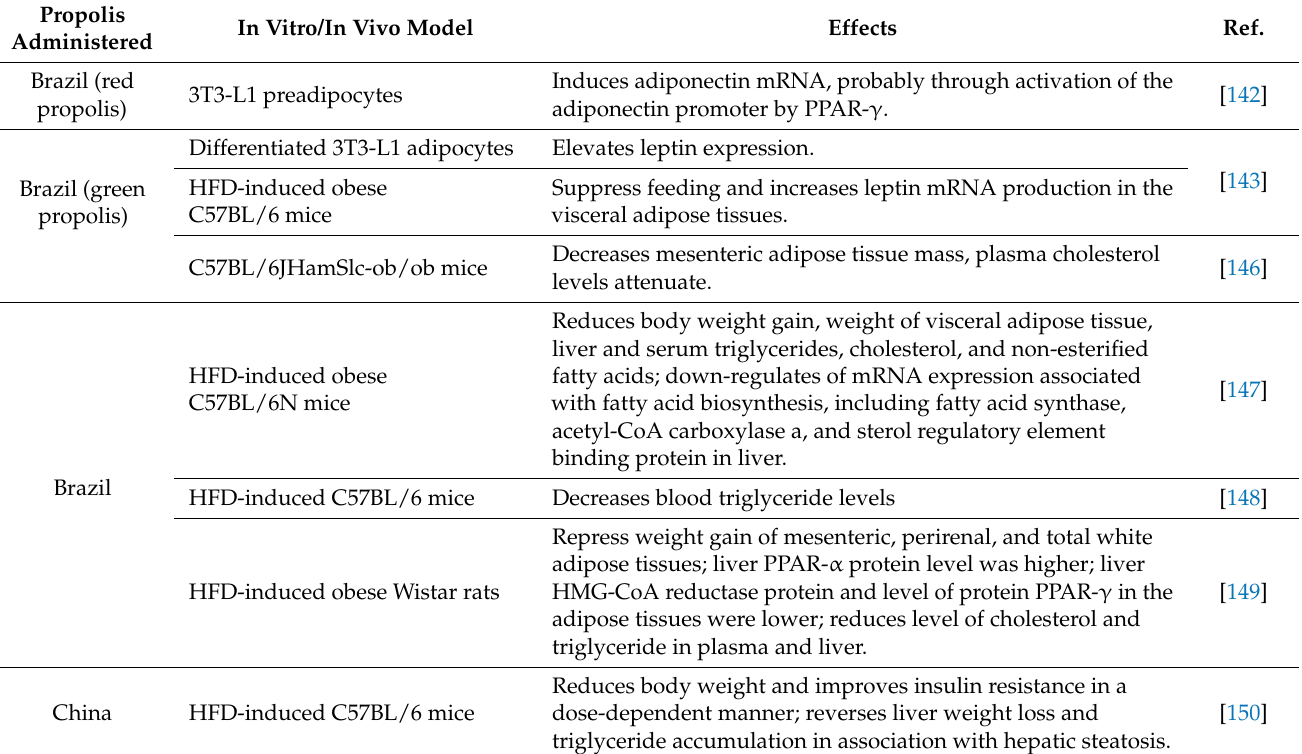
Table 5. Efficacy of propolis in the regulation of obesity-related